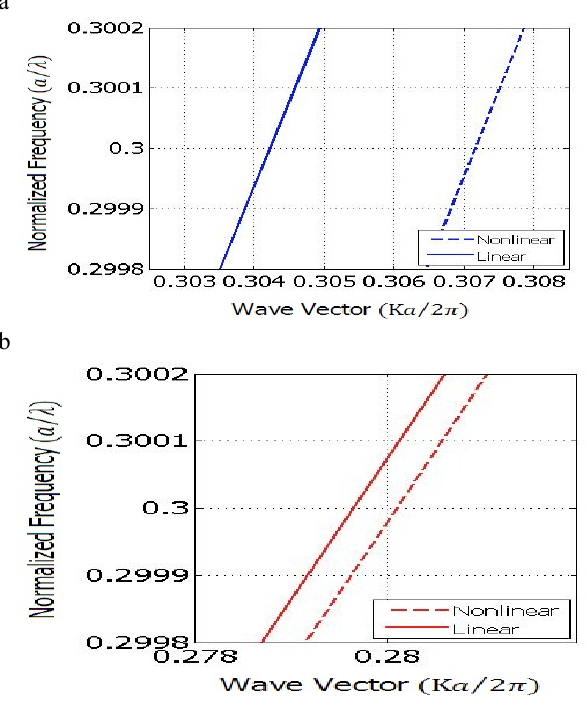
Figure 4: Distribution of the refractive index change within the control waveguide when an intense control signal is applied.